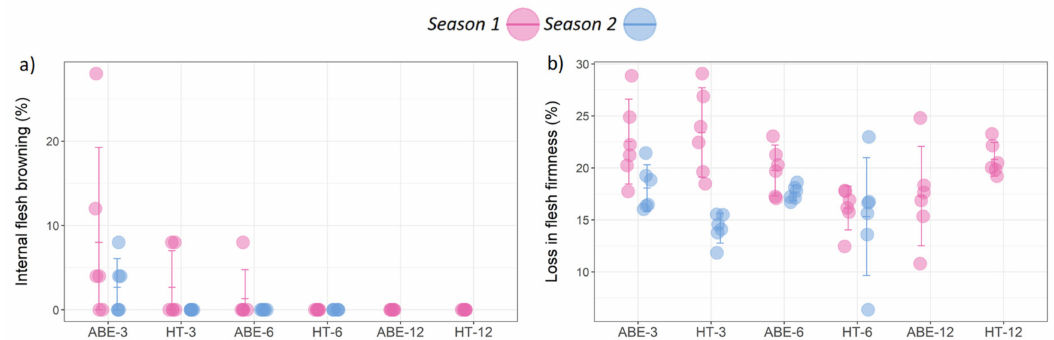
Figure 8. Effect of thinning regime and crop load on physiological disorders: ( a ) internal flesh browning and ( b ) loss in flesh firmness during storage (error bars represent 95% confidence interval). ABE = artificial bud extinction; HT = hand thinned.